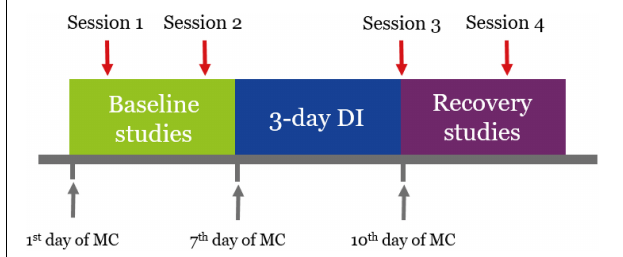
FIGURE 1 | Schedule of the experiment. Sessions 1 and 2 were conducted 5 and 3 days before the start of DI. Session 3 was conducted on the day of DI completion. Session 4 was conducted 3 days after DI. Every experimental stage started on a specific day of the